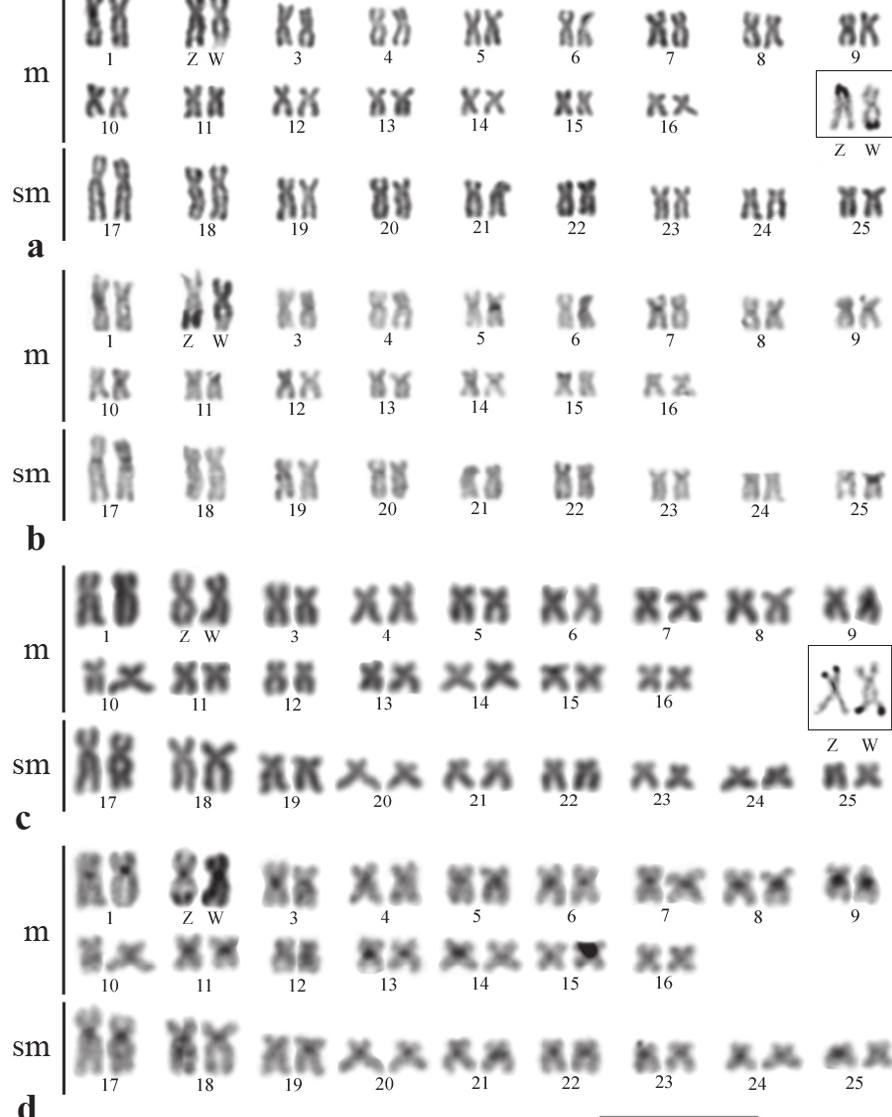
Fig. 5. Karyotypes of the female specimen of Characidium lauroi from Ubatuba, SP, and Characidium lanei from Morretes, PR, after conventional Giemsa staining (a, c) and C-banding (b, d), respectively. Note the different patterns of heterochromatic blocks on the chromosomes and the differentiated sex chromosomes, being the W almost completely heterochromatic in both species. In the box, the Z and W chromosomes carrying the NORs in an inverted position. Scale bar = 10 µm.